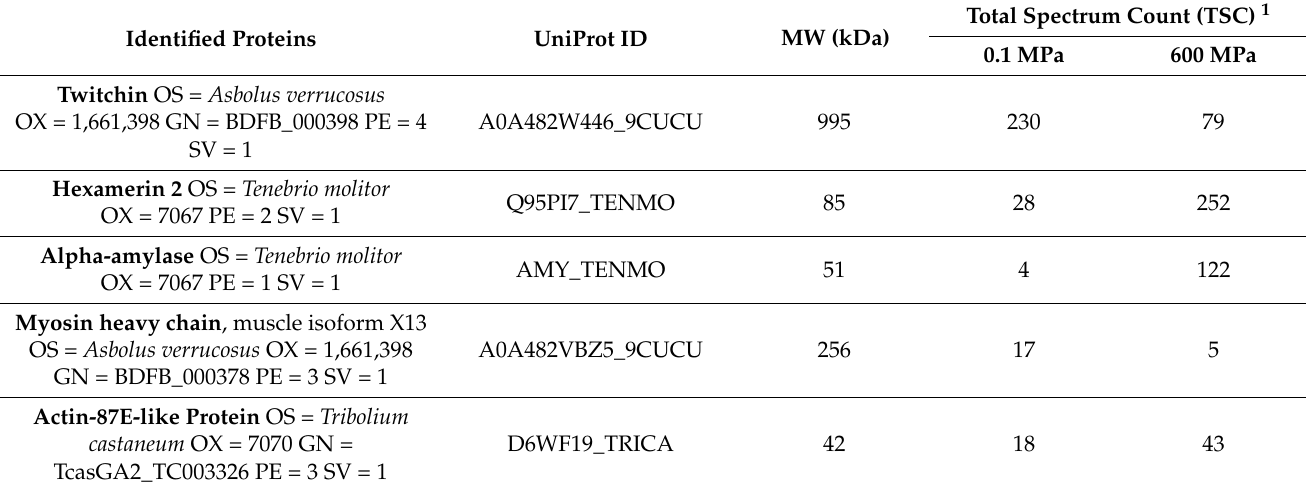
Table 2. Proteomic analysis of native PAGE wells (X 1 ) of control (0.1 MPa) and HHP-treated (600 MPa) mealworm protein